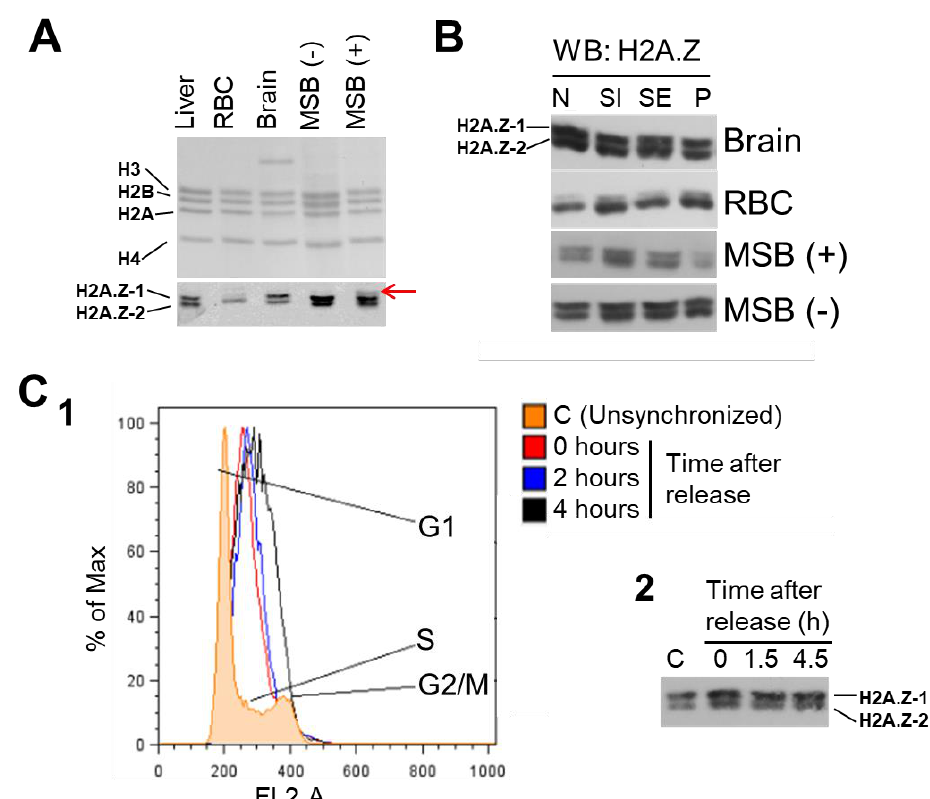
Figure 5. A) Chicken tissue, B) chromatin, and C) cell cycle distribution of chicken H2A.Z-1 and Figure 5. ( A ) Chicken tissue, ( B ) chromatin, and ( C ) cell cycle distribution of chicken H2A.Z-1 and H2A.Z-2 isoforms in MSB cells before (-) and after ( + ) sodium butyrate treatment. The red arrow in (A), points to a band with higher mobility than H2A.Z-1 which appears after sodium butyrate treatment. (B) N = starting nuclei; SI = soluble chromatin fraction obtained immediately after micrococcal nuclease (MNase) digestion; SE = hypotonically released chromatin fraction; P = insoluble chromatin pellet; MSB = Marek’s transformed chicken cells; RBC = red blood cells (chicken). (C 1 ) Distribution of cell cycle phases in unsynchronized (orange) and synchronized MSB cells after 0 (red), 2 (blue), and 4 (black) hours of release from thymidine block. Cells display typical proportional increase in the S phase after synchronization and progression to G2 / M phase. (C 2 ) Western blot of the H2A.Z composition